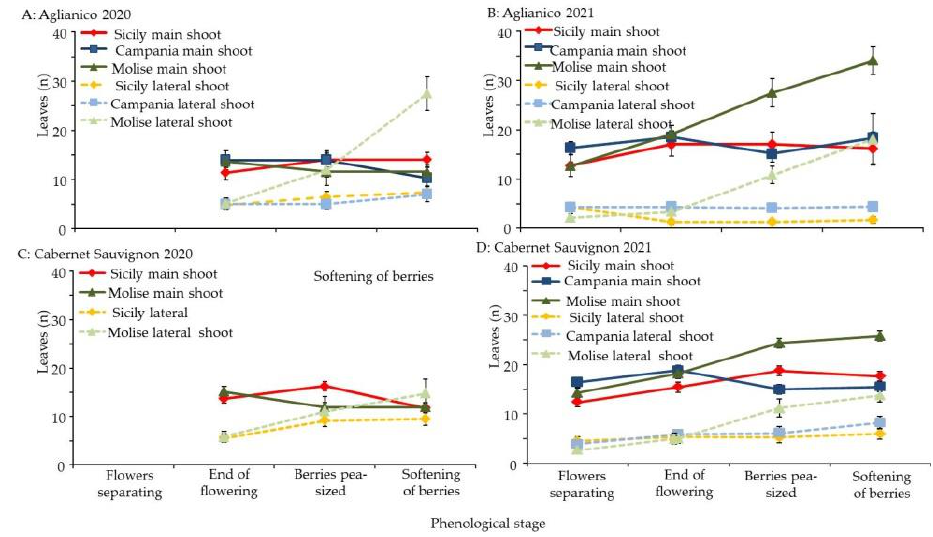
Figure 3. Numbers of leaves from main and lateral shoots recorded in two cultivars, Aglianico (AGL) and Cabernet Sauvignon (CAB), grown in three different sites, Molise (MOL), Campania (CAM), and Sicily (SIC), over two years ( A ): AGL 2020; ( B ): AGL 2021; ( C ): CAB 2020; ( D ): CAB 2021). Measurements were made at the phenological stages BBCH57 (only in the second year) flowers separating, BBCH69 end of flowering, BBCH75 berries pea-sized, and BBCH85 softening of berries (bars indicate one standard deviation), based on Tukey’s HSD test within sites and years. In both years, at each phenological stage, the leaf areas from the main shoots were always higher for AGL (Figure 4). In CAB, for the leaves on the lateral shoots in MOL and CAM at end of flowering in 2020, and in MOL at the pea-sized berries stage and at berry softening stage in 2021, the leaf areas were higher than those for the main shoots. In SIC, the lowest leaf area values were recorded for both the main and the lateral shoots.